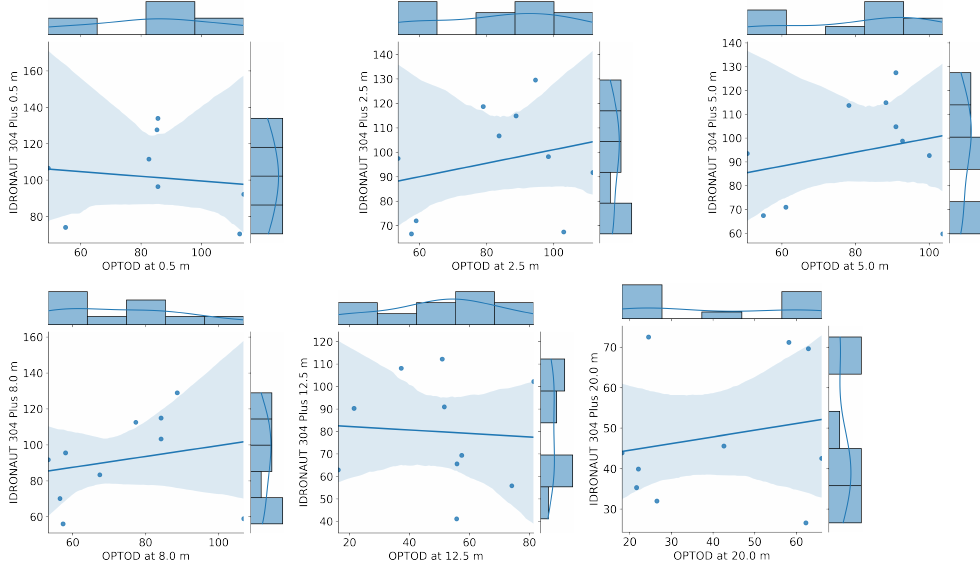
Figure 19. Point to point comparison of dissolved oxygen saturation time series between AHFM and manual sampling with an IDRONAUT 304 Plus probe.